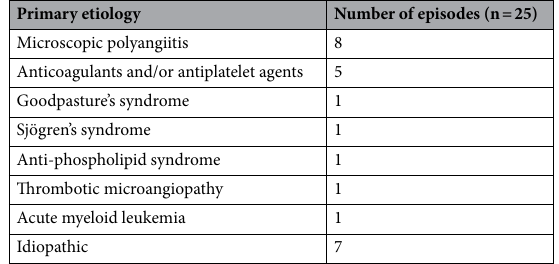
Table 1. Primary etiology of the patients with DAH. DAH, diffuse alveolar hemorrhage.